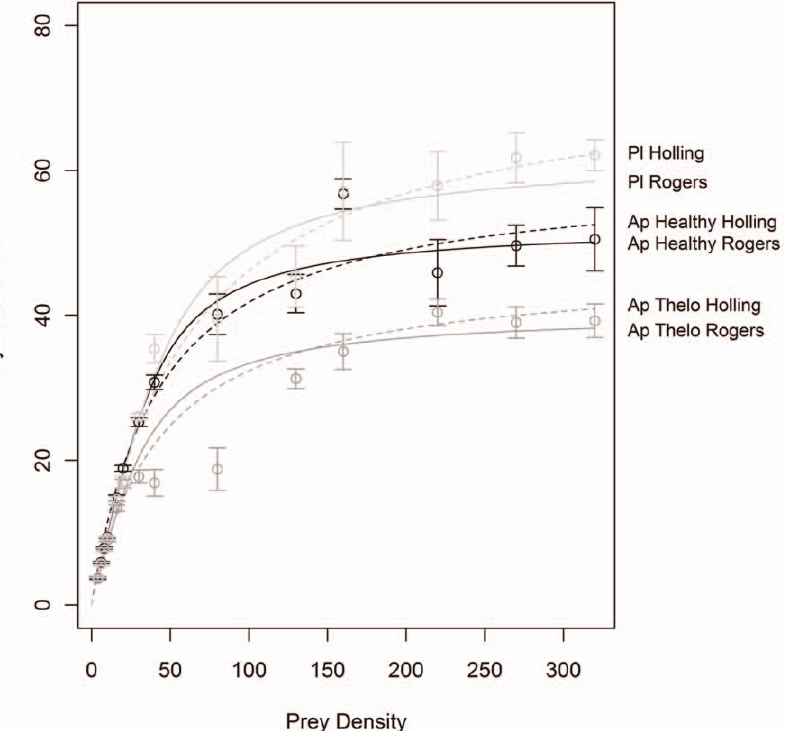
Figure 4. Holling type II (dashed lines) and Rogers random-predator (solid lines) functional response curves for crayfish. Healthy A. pallipes (Ap healthy), A. pallipes with T. contejeani (Ap thelo), and P. leniusculus (Pl) at different densities of Gammarus pulex . Circles represent mean number of prey consumed and vertical bars represent one standard error. doi:10.1371/journal.pone.0032229.g004 PLoS ONE |